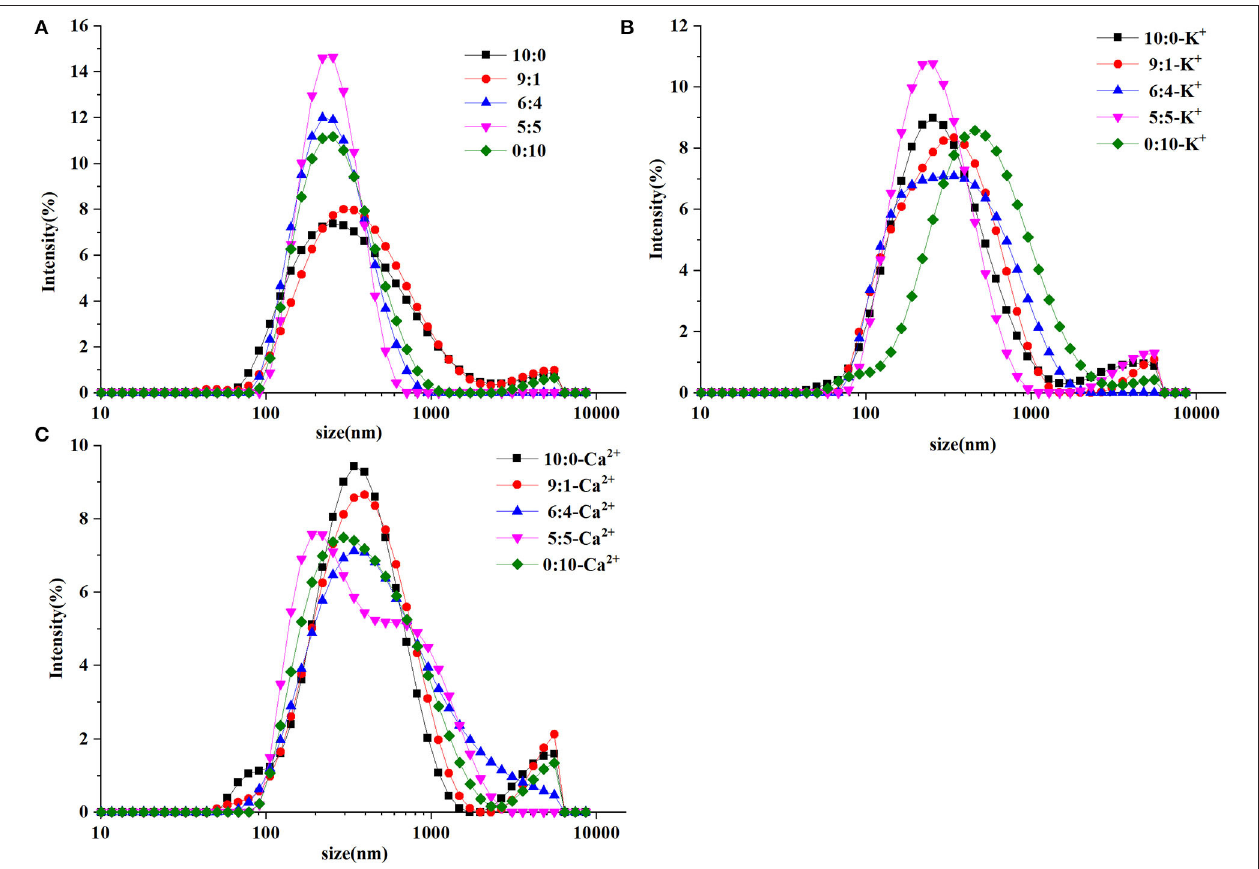
FIGURE 1 | Particle size distribution of control (A) , containing K + (B) , and Ca 2 + (C) of 1,3-dioleoyl-2-palmitoylglycerol (OPO) emulsions (10% v/v OPO human milk fat substitutes) with different ratios of whey protein isolate (WPI) and caseinate (CN; 10:0, 9:1, 6:4, 5:5, 0:10, 1% w/v in total) as emulsifiers. destabilization kinetics was evaluated by measuring creaming index as the percentage of serum layer height ( H S ) from the total emulsion height ( H T )